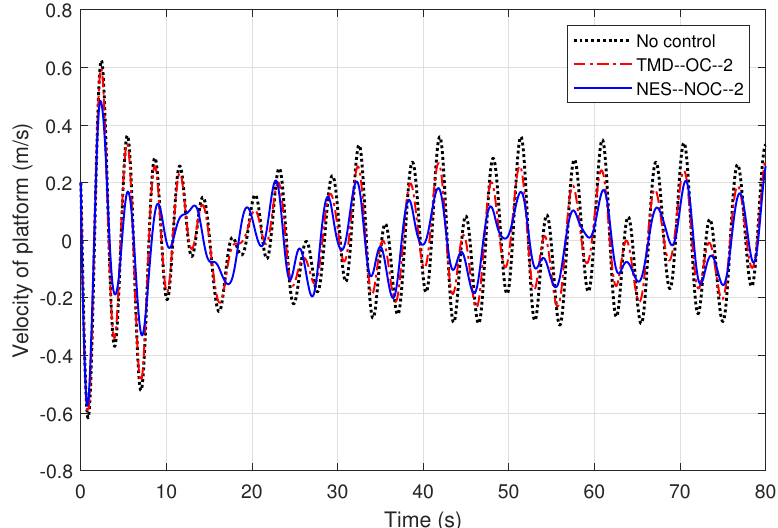
Figure 17. Velocities of the structure without control, with TMD–OC–2 and NES–NOC–2.